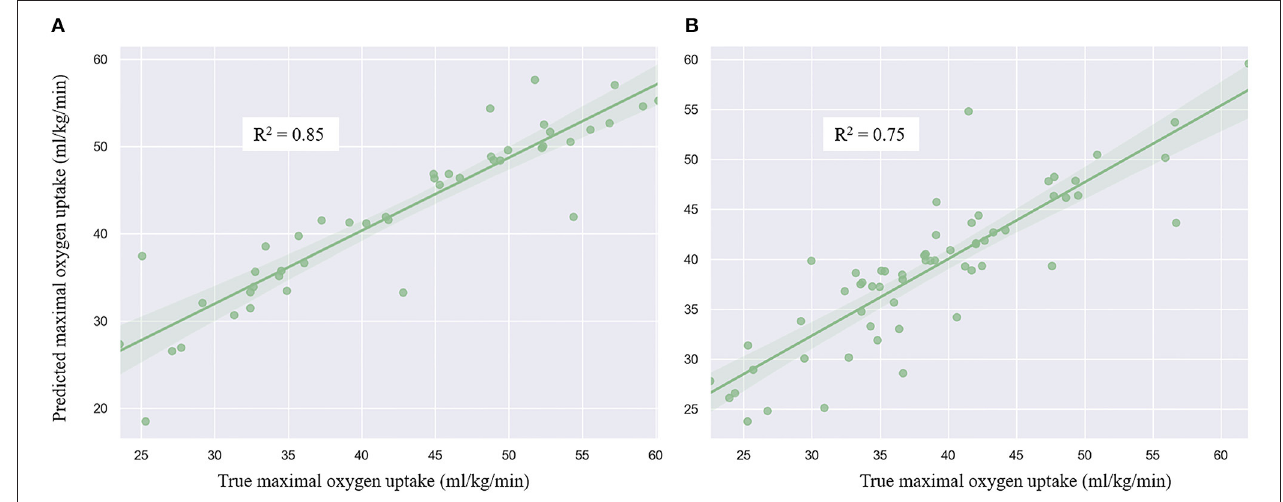
FIGURE 5 | Regression plot of the linear regression model of age 21–40 group (A) and age above 40 group (B)